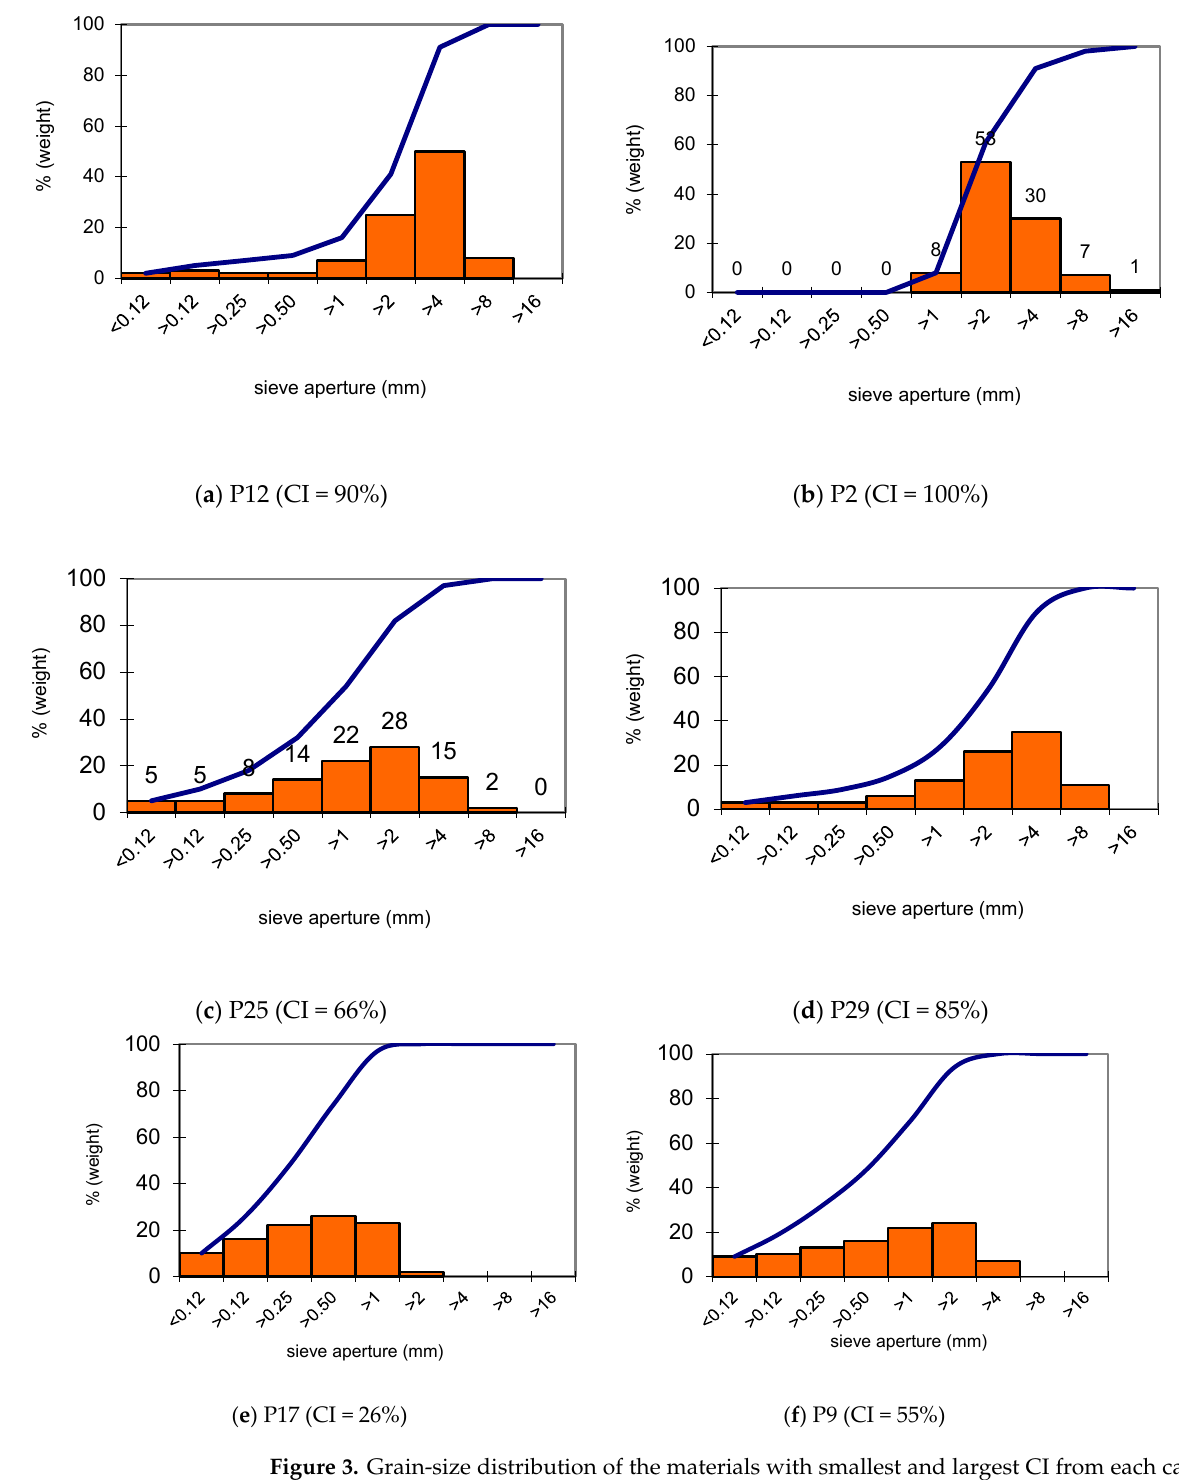
gory: ( a , b ) coarse tephras; ( c , d ) intermediate tephras and ( e , f ) fine tephras. ( a , b ) coarse tephras; ( c , d ) intermediate tephras and ( e , f ) fine